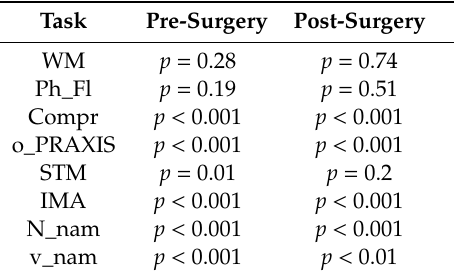
Table 4. Results of the student t -test or Wilcoxon test comparing pre-surgery (T3) to post-surgery (T4) patients’ level of performance. Task T3